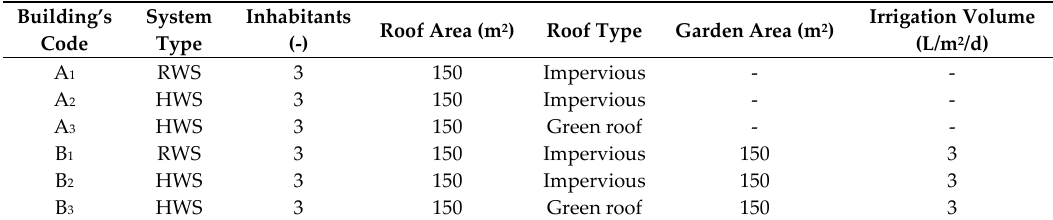
Table 1. Building’s code, decentralized system type, number of inhabitants, roof area, type of cover roof, garden area and irrigation